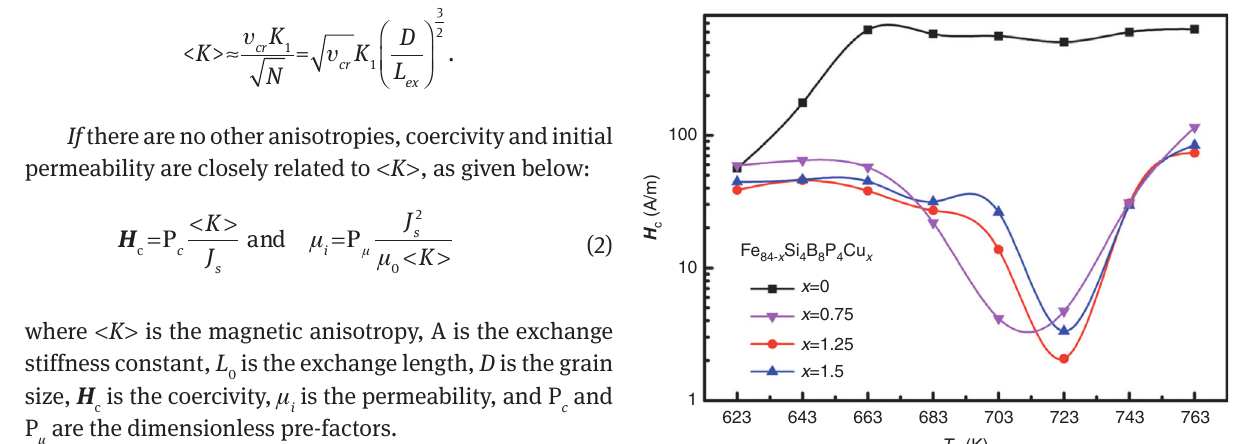
Figure 5 Changes in H annealing temperature for 1.8 ks (Kong et al. [14], Copyright AIP 2011).